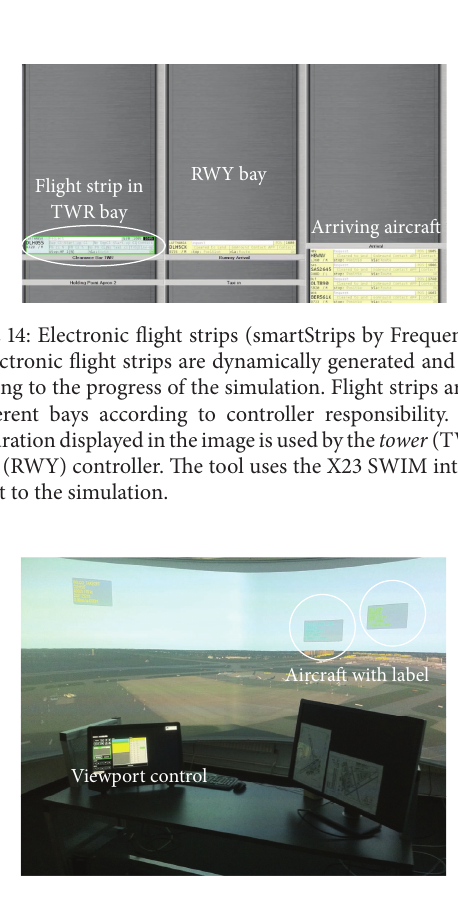
Figure 15: Virtual tower view of Hamburg Airport (X-Plane by Laminar Research). The viewport control is used to pan and zoom the projection. Aircraft are augmented with labels containing air traffic management